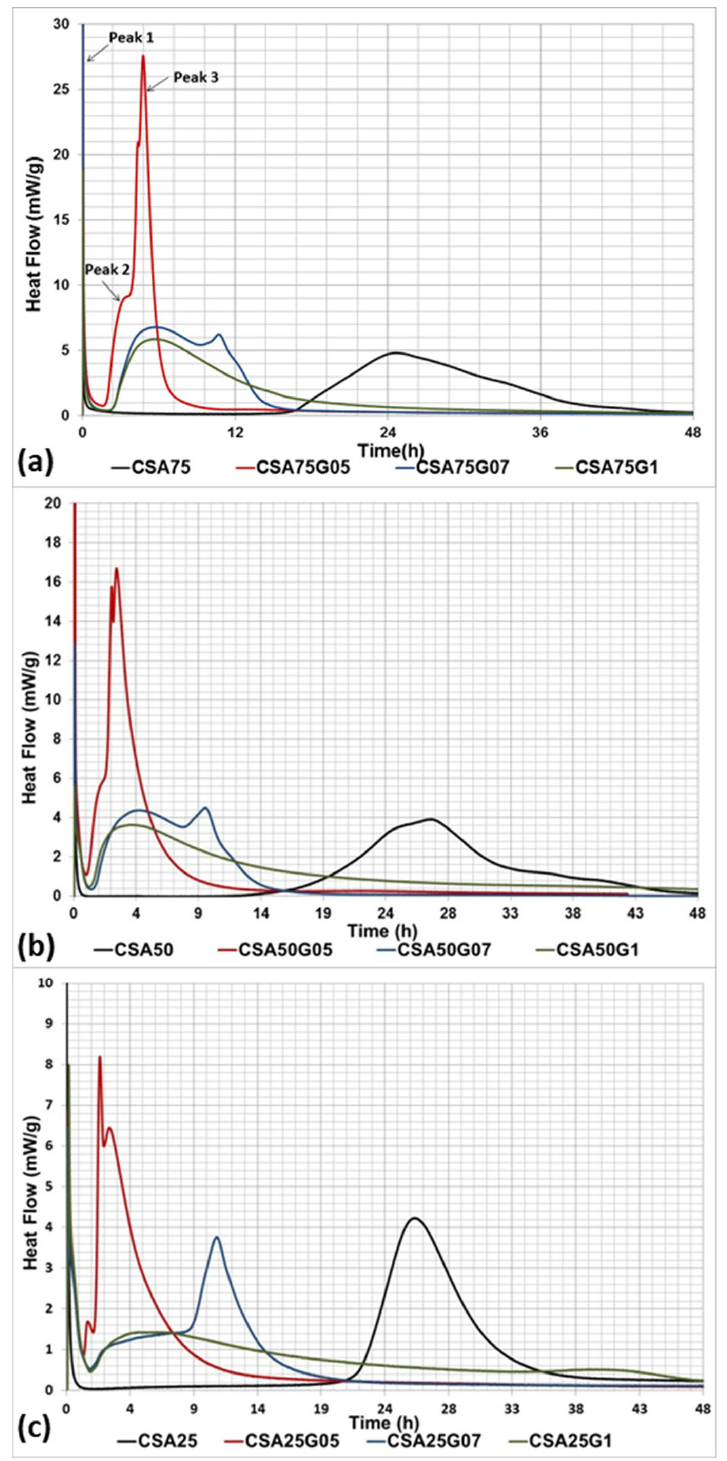
Figure 2. Heat hydration versus time of cement pastes containing ( a ) 75 wt. % ye’elimite, ( b ) 50 wt. % ye’elimite, and ( c ) 25 wt. % ye’elimite, with different SO 3 /Al 2 O 3 ratios (0.5, 0.7, and 1 for CSA75G05, CSA75G07, and CSA75G1, respectively).